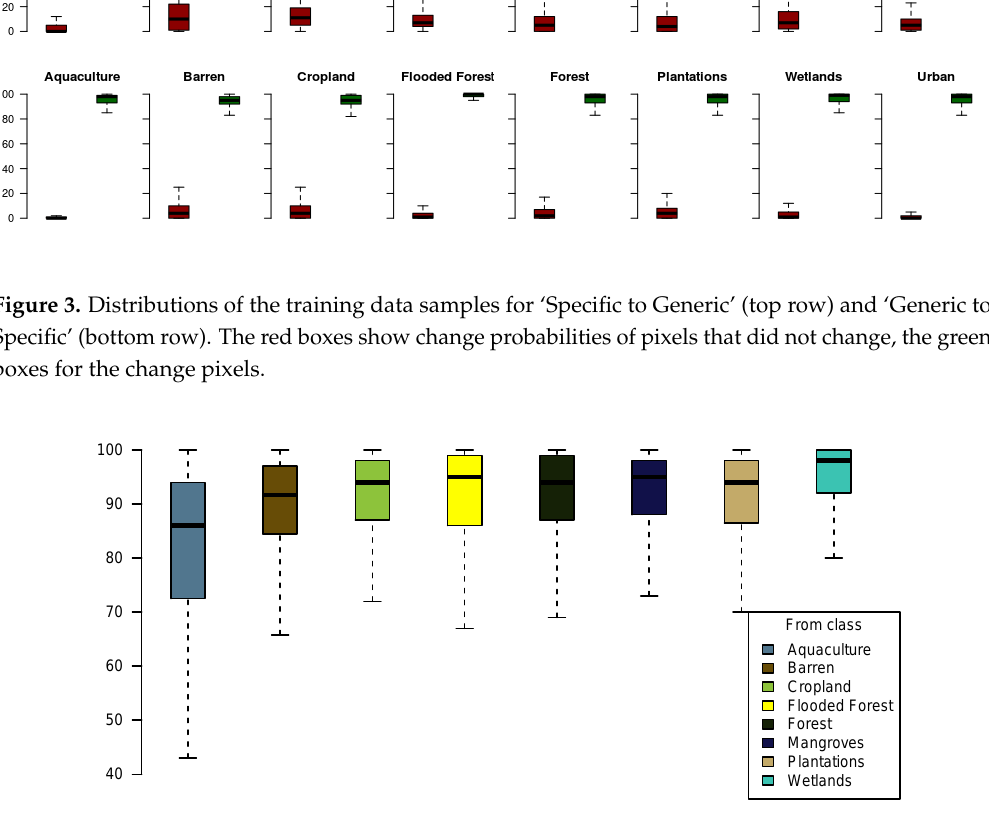
Figure 4. Distributions of validation change pixels in the ‘Specific to Generic’ category.